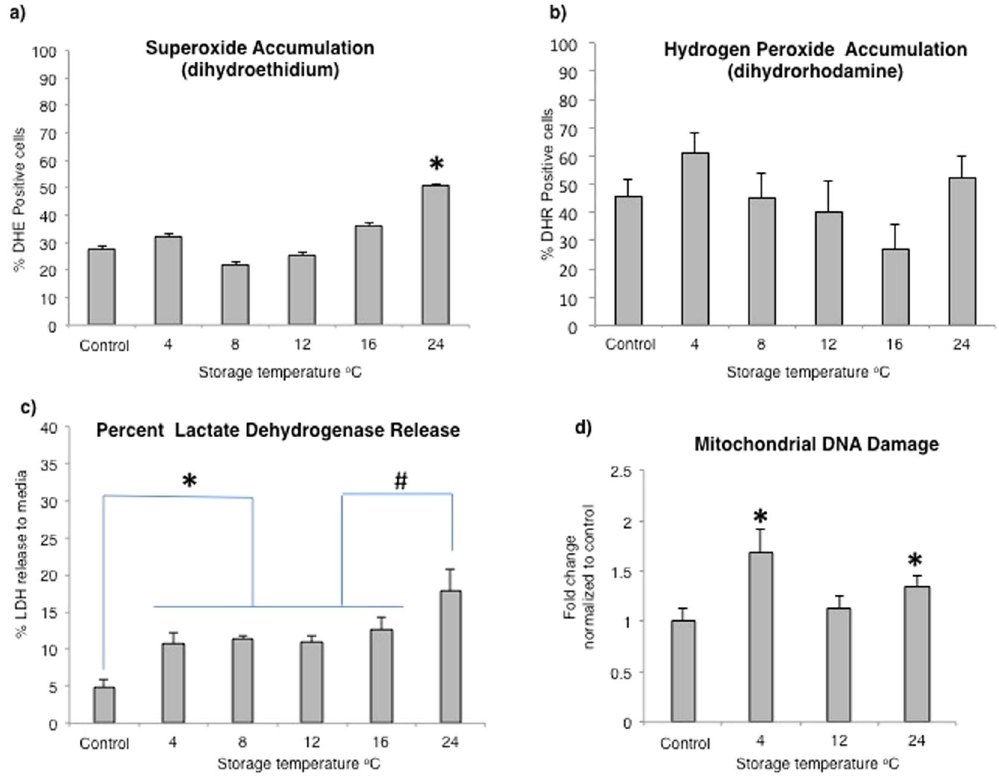
Figure 3. Mitochondrial reactive oxygen species and damage to macromolecules. ( a ) Mitochondrial superoxide anion level as indicated by dihydroethidium fluorescence ( * = significantly increased compared to control; p ≤ 0.05). ( b ) Mitochondrial peroxyl levels as indicated by dihydrorhodamine fluorescence compared to control. ( c ) Membrane damage, indicated by percent lactate dehydrogenase release ( * = significantly increased compared to control; # = significantly increased compared to other temperature groups; p ≤ 0.05). ( d ) Fold change mtDNA damage ( * = significantly increased compared to control; p ≤